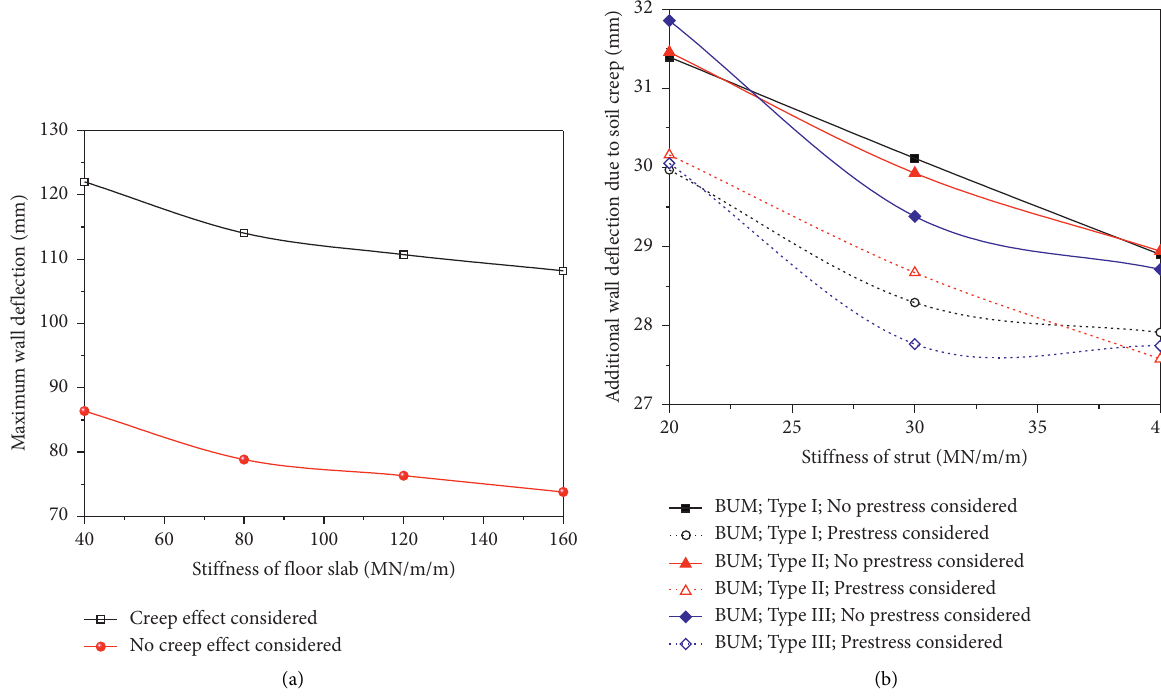
Figure 3: Soil creep effect on wall deflection in cases of (a) TDM; (b) BUM, modified from [32].